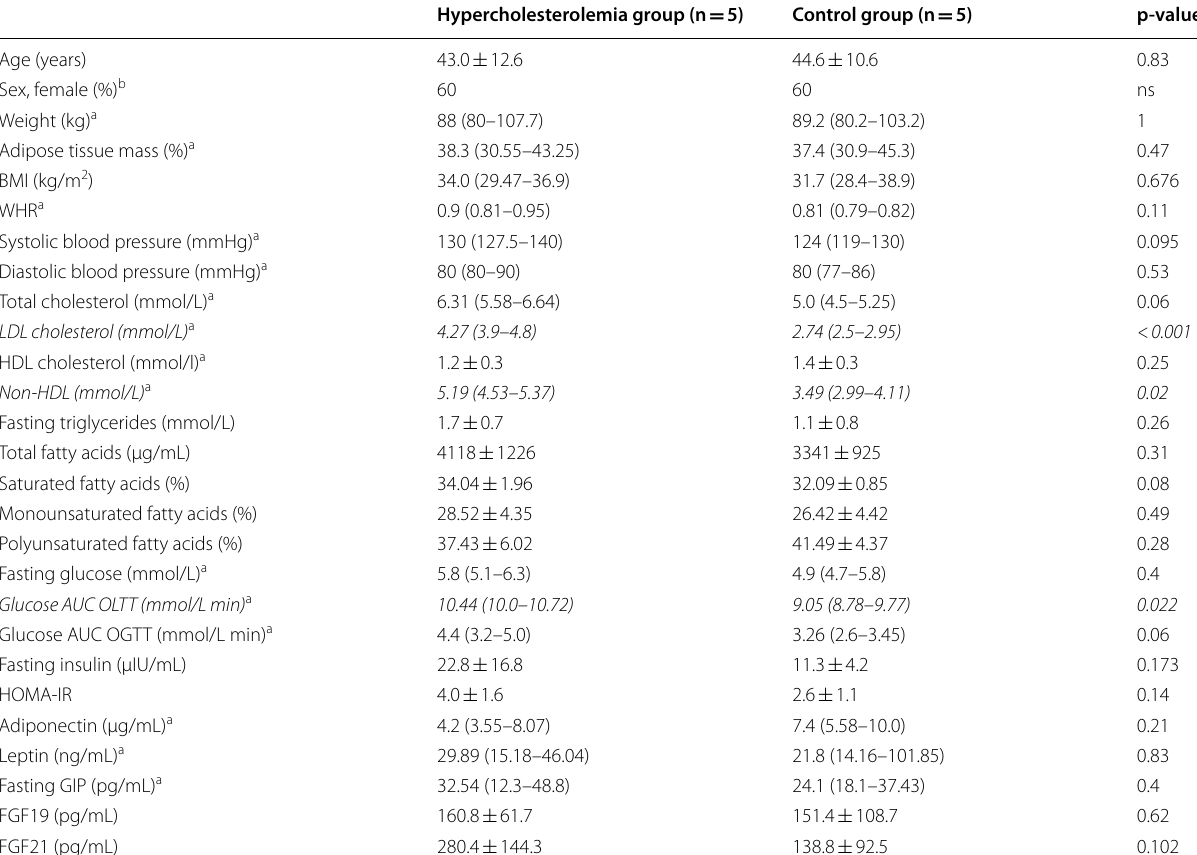
Table 1 Characteristics of subjects selected for DNA methylation